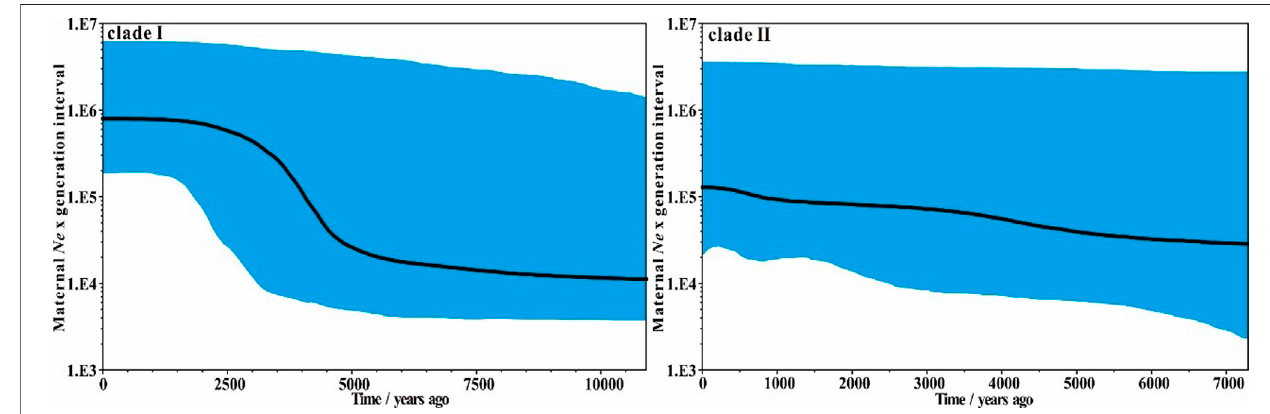
FIGURE 4 | Bayesian skyline plot of the two different domestic donkey lineages based on near-complete mitochondrial genomes. Black line indicates median female N e change over time, while the shaded blue area indicates the 95% credibility